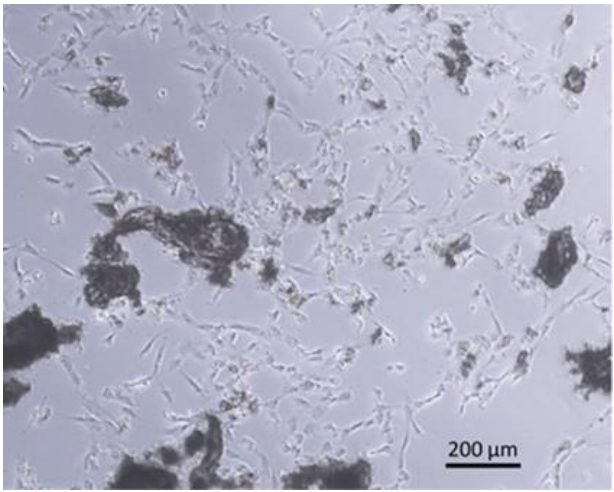
Figure 9. Scanning electron microscope image of cells grown out of in vitro cultured bone chips.